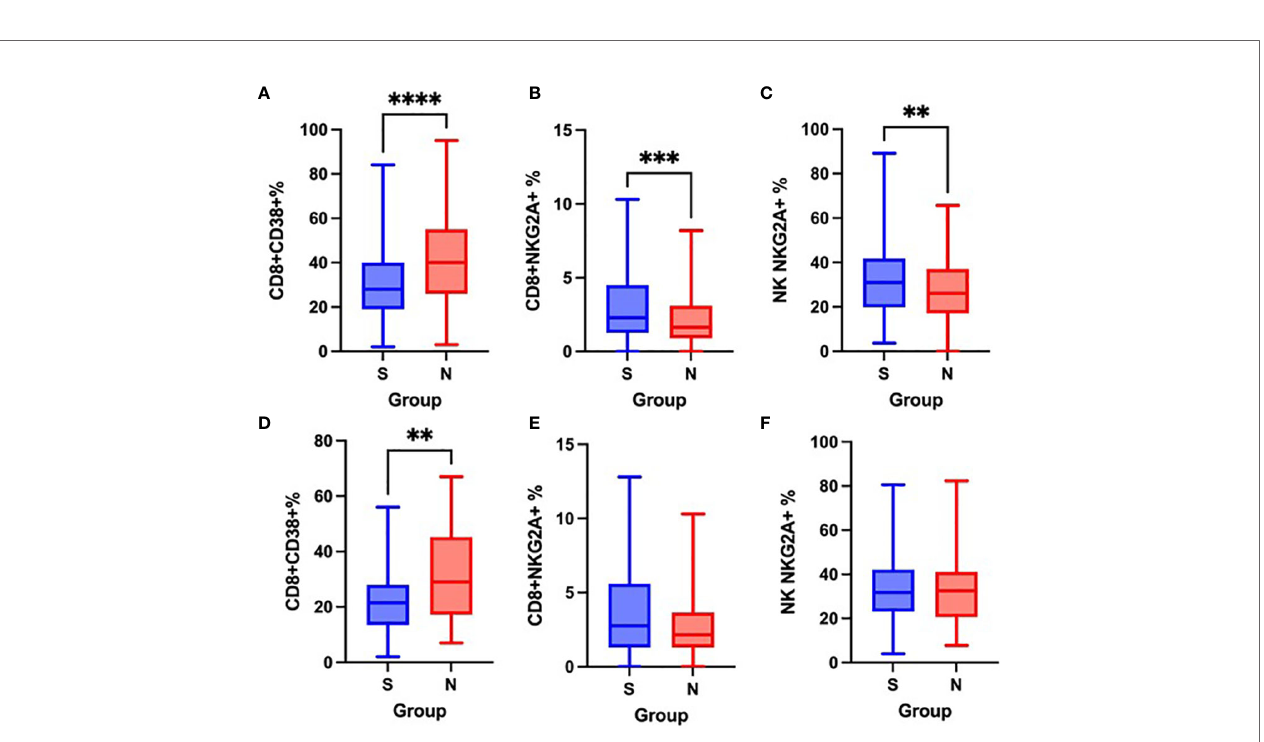
FIGURE 7 | Differences in the proportion of CD8+CD38+ cells on admission (A) and after one week (D) , CD8 + NKG2A + cells on admission (B) and after one week (E) and NK NKG2A + cells on admission (C) and after one week (F) between survivors [S] and non-survivors [N], Mann-Whitney test. **p < 0.01; ***p < 0.001; ****p < 0.0001.